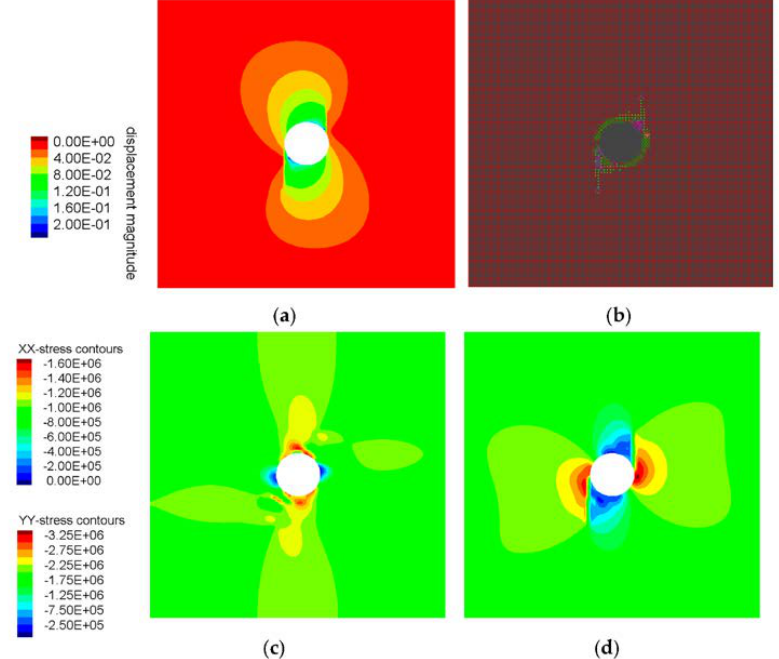
Figure 21. Simulation results for tunnel model with joint orientation of −60° and κ = 2: ( a ) displacement contours [m], ( b ) plasticity state, ( c ) contour plot of horizontal stresses [Pa] and ( d ) contour plot of vertical stresses [Pa]. Energies 2018 , 11 , x FOR PEER REVIEW